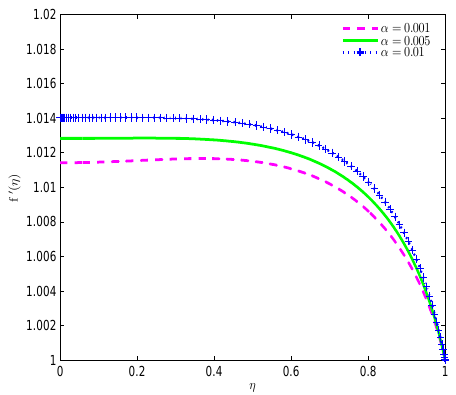
Fig. 2: Variation of f (cid:48) with α at β = 0.005 , γ = 0.01 , Re = 10.0 , K = 10.0 and Λ = 0.001